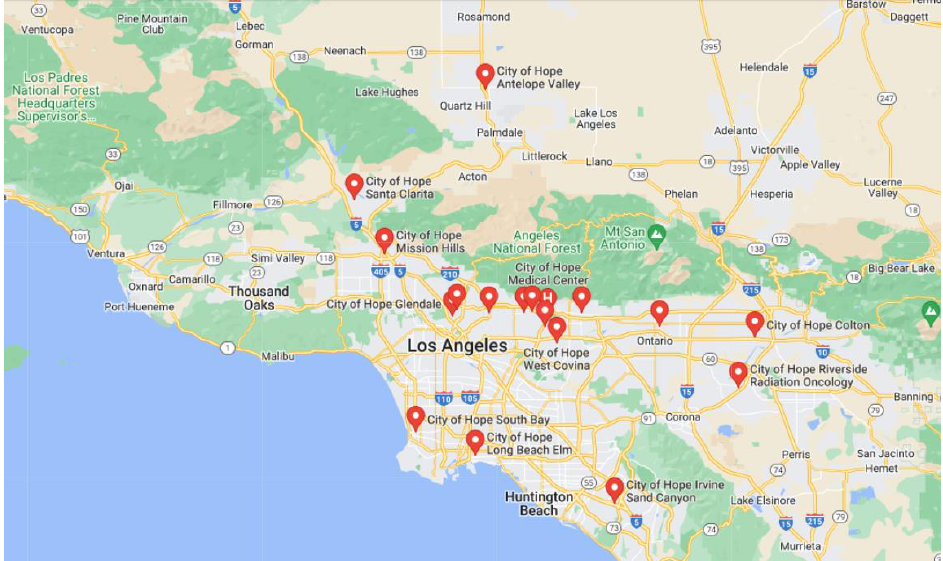
Figure 1. Map of City of Hope locations in Southern California. Teardrop with “H” represents COH main campus at Duarte, California, where the T-VEC treatment is performed. Other red teardrops represent 18 out of 27 campuses in City of Hope.